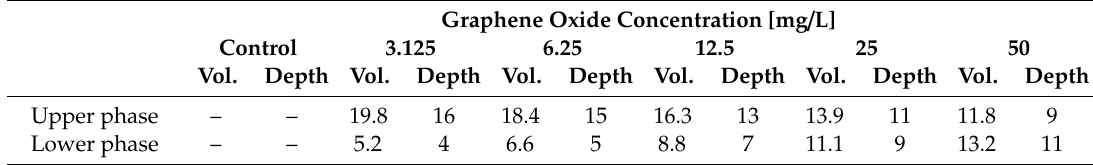
Table 2. Volume (mL) and depth (mm) of the clear, GO-depleted upper phase and the GO-rich lower phase in the assembled test systems after 48 h of an exposure period.